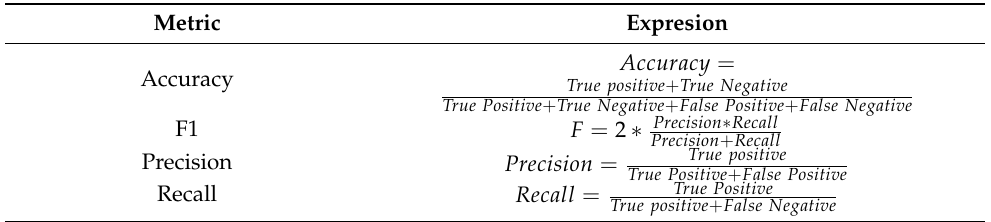
Table 3. Metric’s